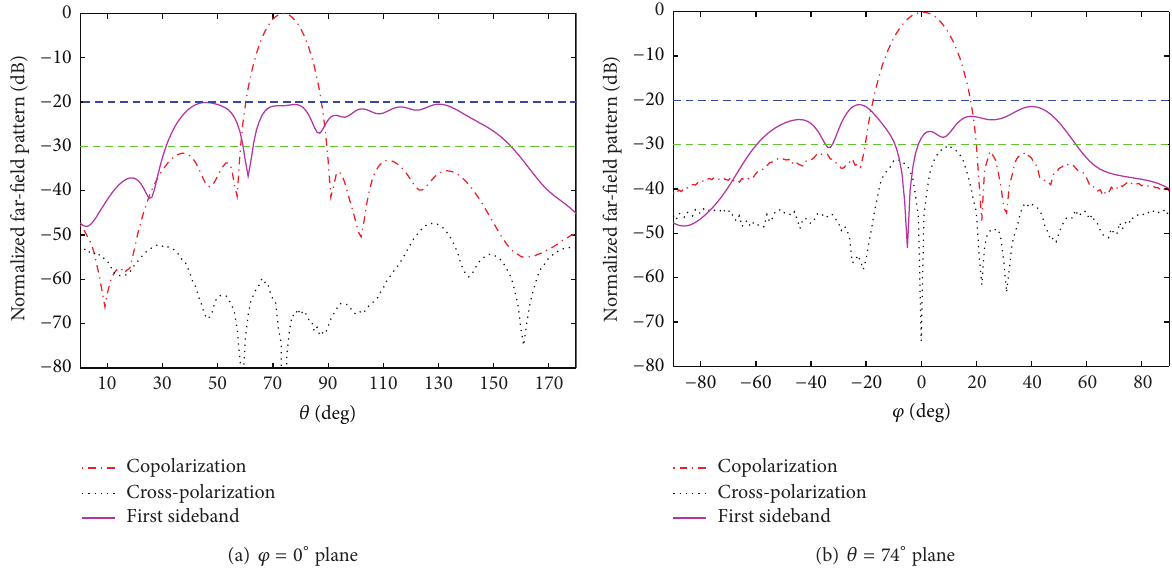
Figure 9: Sectional views in the elevation and azimuth planes for scan direction of (74 ∘ , 0 ∘ ) for solution A in Figure 7.